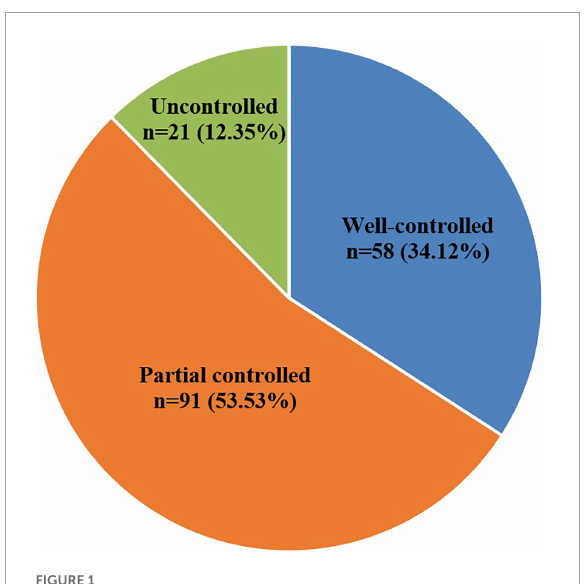
FIGURE1 The ratio of improvement for AR patients after 6 months